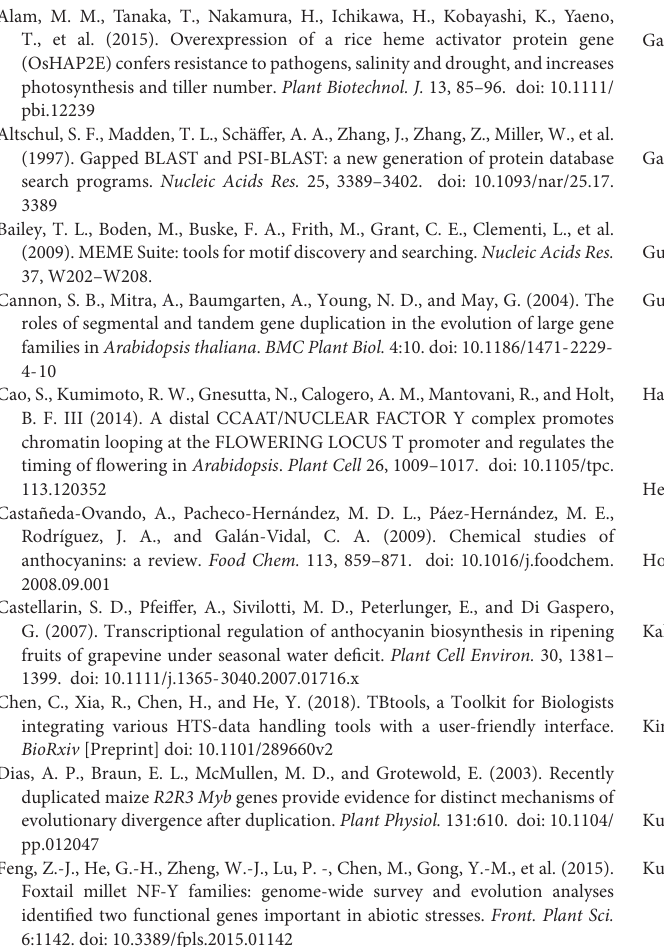
Supplementary Table 7 | RNA-seq data of StNF-Y genes in different tissues.